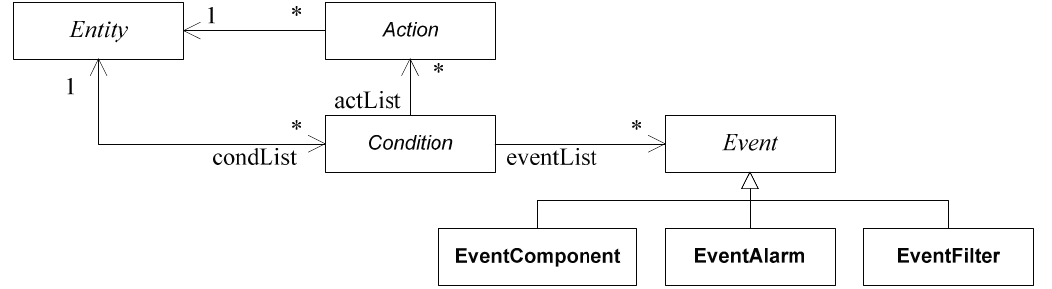
Figure 14. UML class diagram of the proposal